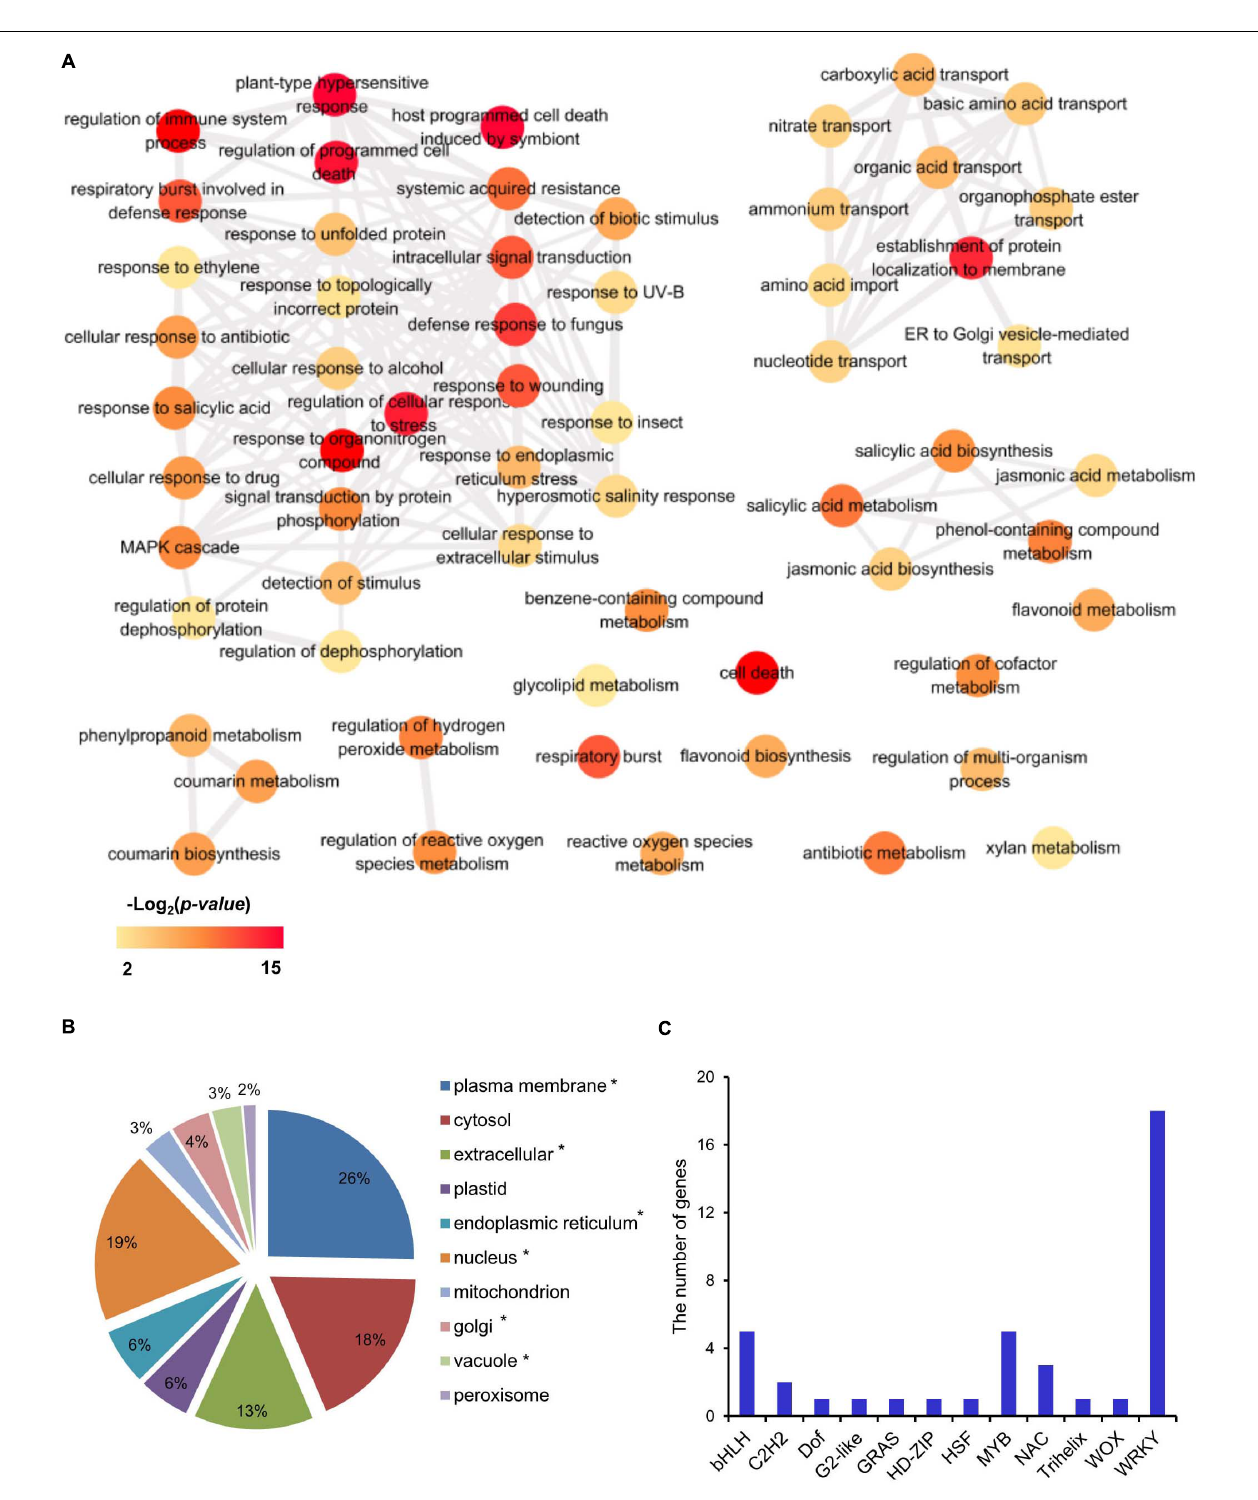
FIGURE 3 | Transcriptomic analysis of common differentially expressed genes (CGs) in mutant vs. wild type in Les4 , Les10 , and Les17. (A) Biological process of gene ontology (GO) term analysis of CGs. The GO term analysis was conducted in R with packages “clusterProfiler.” The full list of significant GO terms ( Supplementary Table 5 ) assigned into biological process were subjected into REViGO (http://revigo.irb.hr/) to redundant GO terms, and visualized in Cytoscape. The color indicated the significance [ − Log 2 ( p -value)] of GO terms. Only significant GO terms were shown. (B) The proportion of cellular location of proteins encoded by common genes (CGs) in Les4 , Les10 , and Les17 . The asterisk behind each item indicates that the p -value of the hypergeometric distribution test was lower than 0.05. (C) The gene numbers of each transcription factor family in CGs.